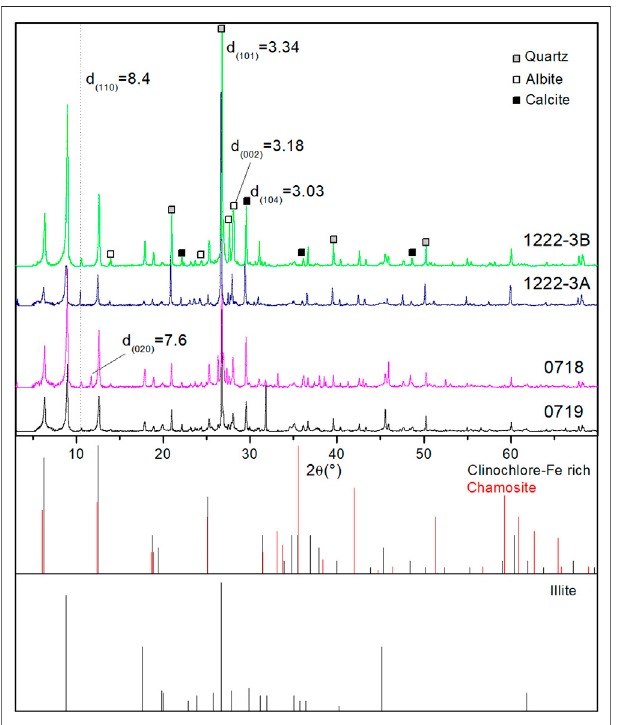
FIGURE 3 | X-ray diffractograms of the four sediment samples.